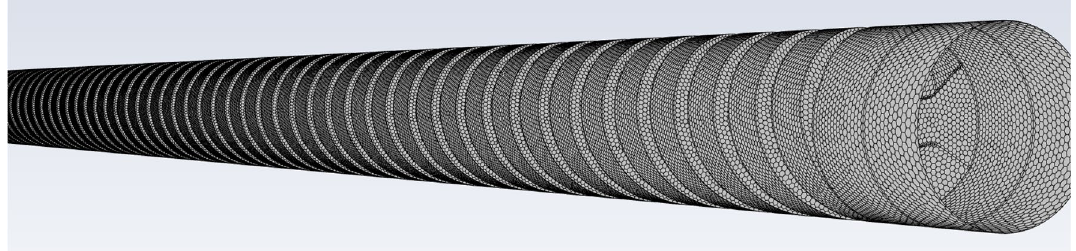
Fig. 8 Meshed CAD of the 3 mm wide–4.5 mm depth channel-28 loop screw geometry